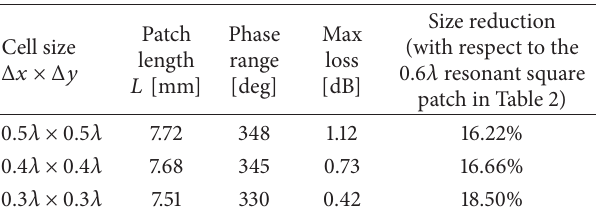
Figure 16: Comparison between simulated phase curve versus 𝑆 for different values of the unit cell size (2nd iteration). Table 3: Fractal unit cell performances (2nd iteration Minkowski